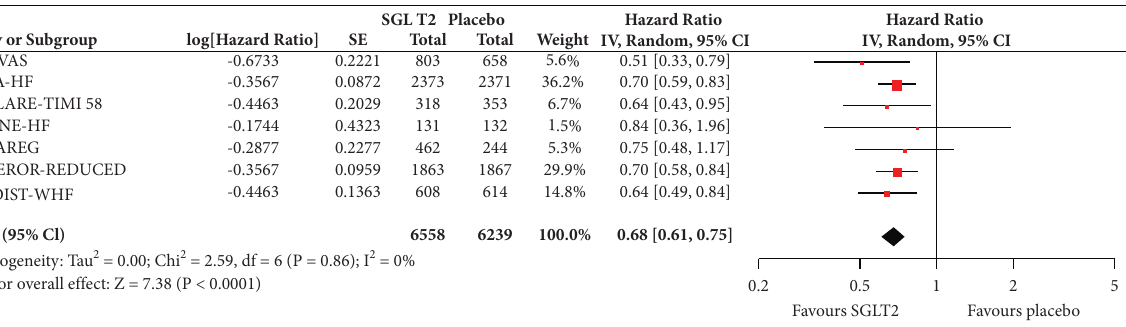
Figure 2: Effect of SGLT2 inhibitors versus placebo on hospitalisation for heart failure for the total population.